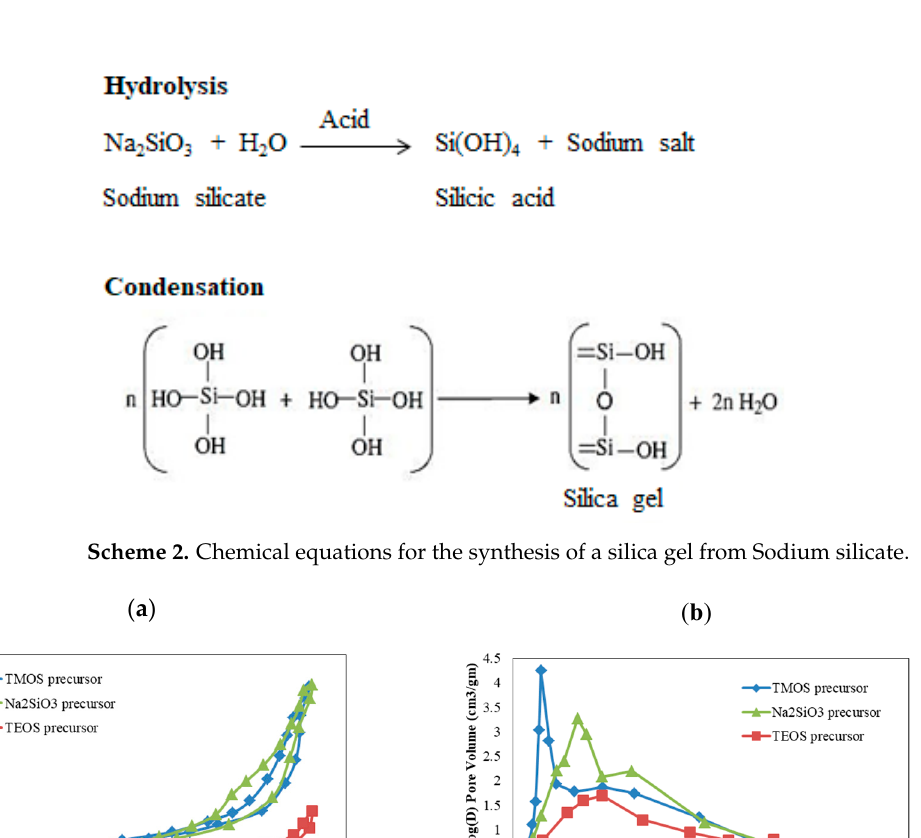
Figure 3. Adsorption–desorption isotherms ( a ) and pore-size distribution ( b ) for TMOS-, TEOS-, and Na 2 SiO 3 -based silica aerogels.